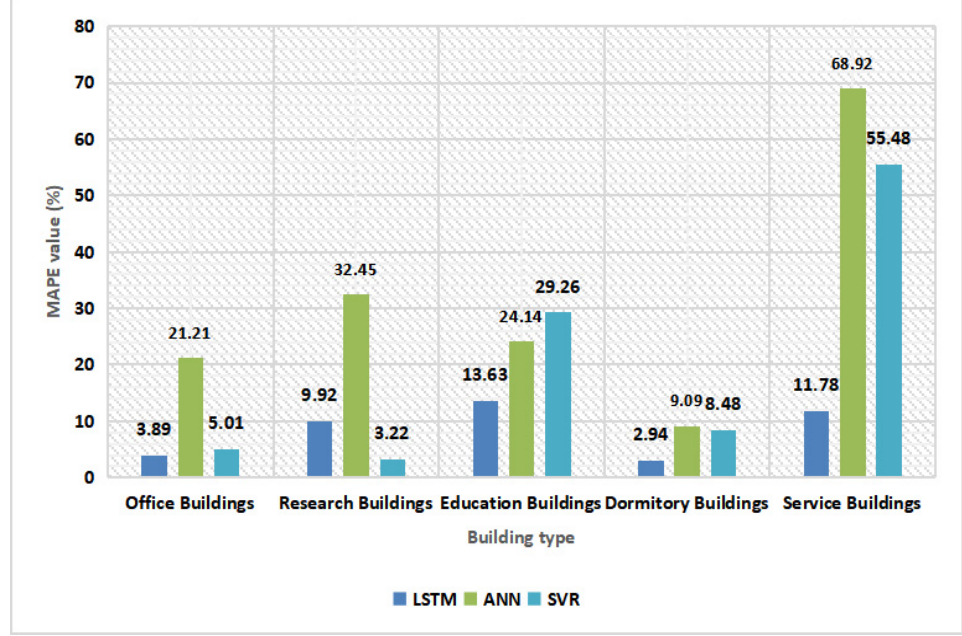
Figure 7. MAPE value for different buildings using LSTM, ANN and SVR models for energy utilization.